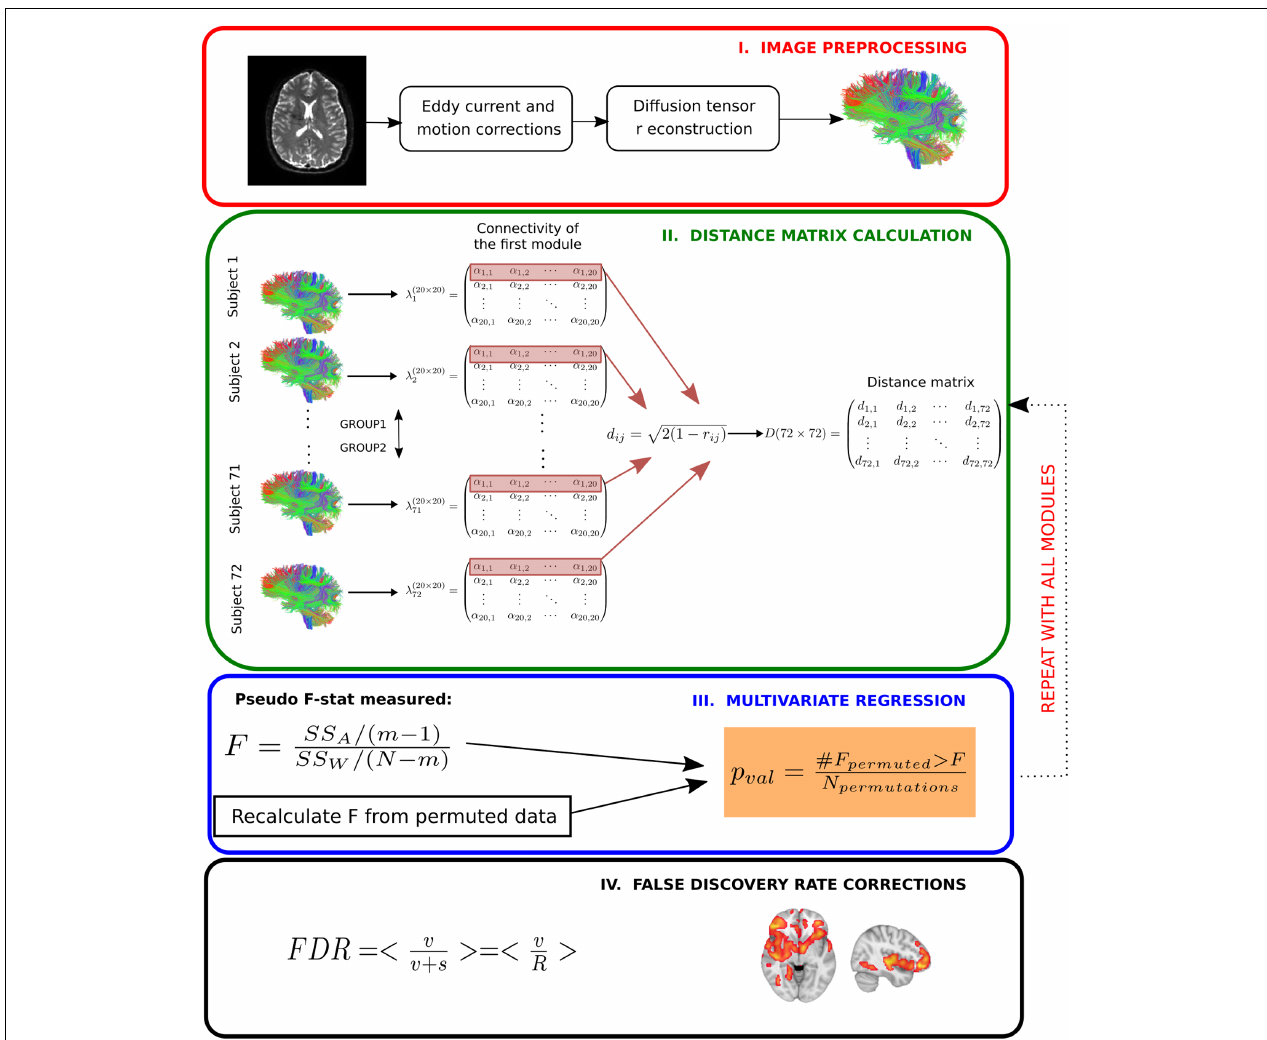
FIGURE 2 | Multivariate distance matrix regression analysis to find differences in brain connectivity patterns across severity progression of AD. In a first step ( Image preprocessing in a red box), brain images are preprocessed by using standard techniques, mainly eddy current and head motion corrections). Next, diffusion tensor reconstructions are built that allows calculating the tractography for each subject (further details in Materials and Methods). In the next step ( Distance matrix calculation in a green box), first the streamline number connectivity matrix is obtained (here, represented by λ ), one per subject, corresponding to 20 × 20 entries of values given by α . Second, the connectivity patterns of subjects for a given module are used to construct the distance matrix in the subject space by means of Pearson correlation coefficients. Once the distance matrix for a given module is calculated (here, we highlight in red the first row that corresponds to the first module), we test in the third step ( Multivariate regression in a blue box) whether the variability in distance between different groups is statistically related with disease, for which we compare the observed results with a simulated distribution given by N permutations of the labels. We repeat this operation for every module. We finally apply the fourth step ( False discovery rate corrections in a black box) to correct for multiple